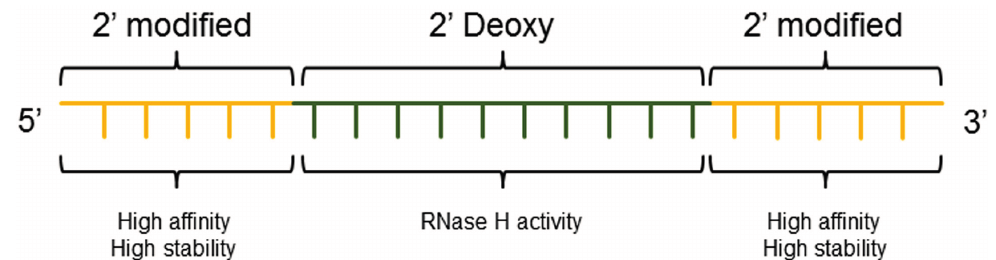
Figure 4. Gapmer. Current generations of ASO are frequently represented by a gapmer of typically 20 nucleotides with predominant phosphorothioate (PS) linkages. The central domain is composed of 8–12 deoxynucleotides that bind RNase H and induce efficient cleavage of the mRNA. At both ends of the gapmer (wings), 2–5 nucleotides having 2 ′ modifications, typically 2 ′ -MOE and 2 ′ -OMe, are inserted. The wings improve overall resistance of ASO to nucleases and increase the affinity to the target